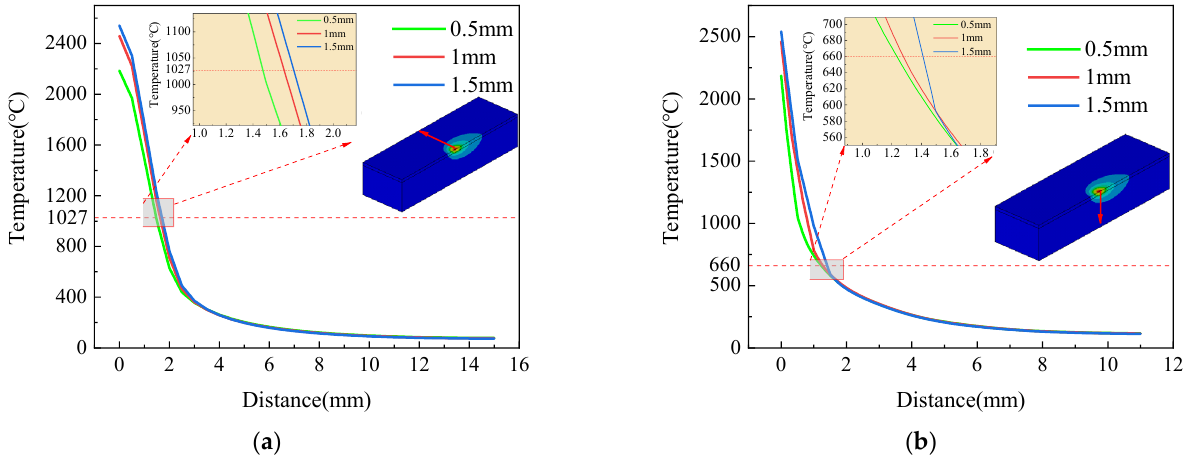
Figure 5. Temperature distribution of different thicknesses along different paths: ( a ) temperature distribution of different thicknesses along the width direction; ( b ) temperature distribution of different thicknesses along the depth direction.